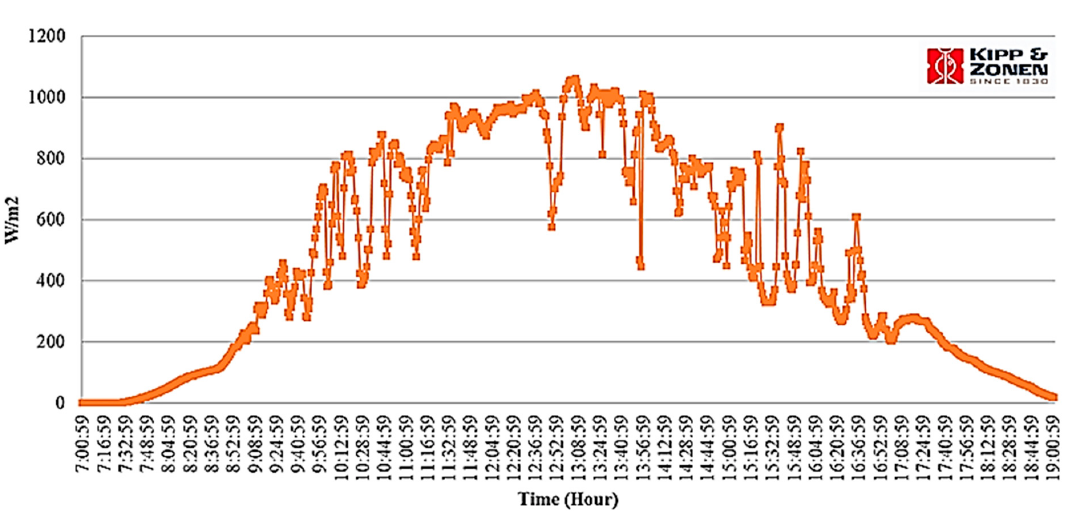
Figure 3. Energy consumption for C1 category commercial sector.